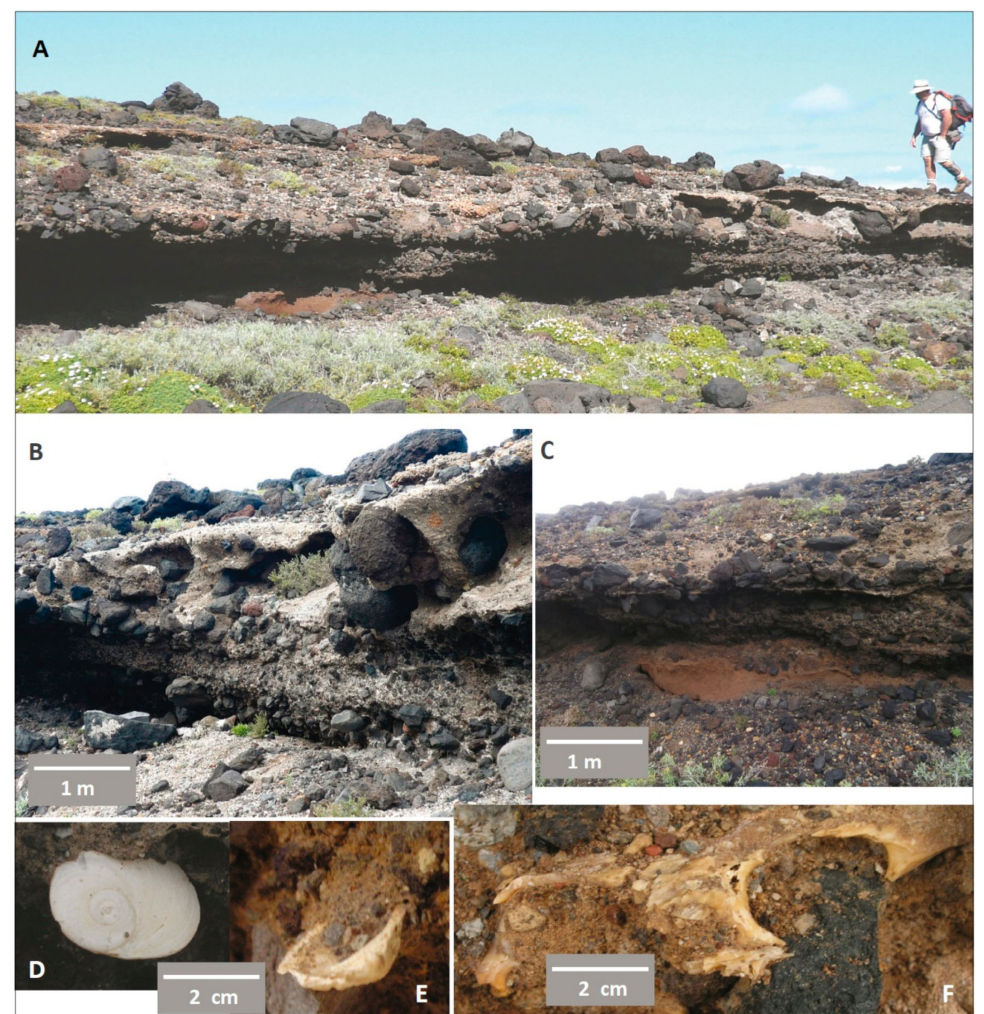
Figure 4. Barranco de Itobal (Teno) deposits. ( A – C ) Fossiliferous breccia with multiple depositional layers, up to 1.8 m thick, showing reverse grading; four to five depositional units can be observed ( B ); ( C ) the tsunami conglomerates overlie an Aeolian sand and dune slack deposit on which a brownish sandy paleosol has developed; ( D – E ) incorporated fossils of bivalves and gastropods, and ( F ) fish